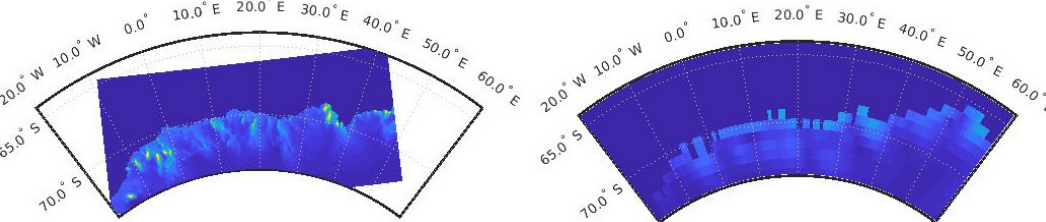
Figure 10. The coast-to-inland gradient of the downscaled CESM2 member 1 averaged over the total period seems in agreement with the averaged reconstruction based on the ice core records of Medley and Thomas (2019) but depicts much more detail, which could be useful in detailed analysis of ice-core-record representativity (same color